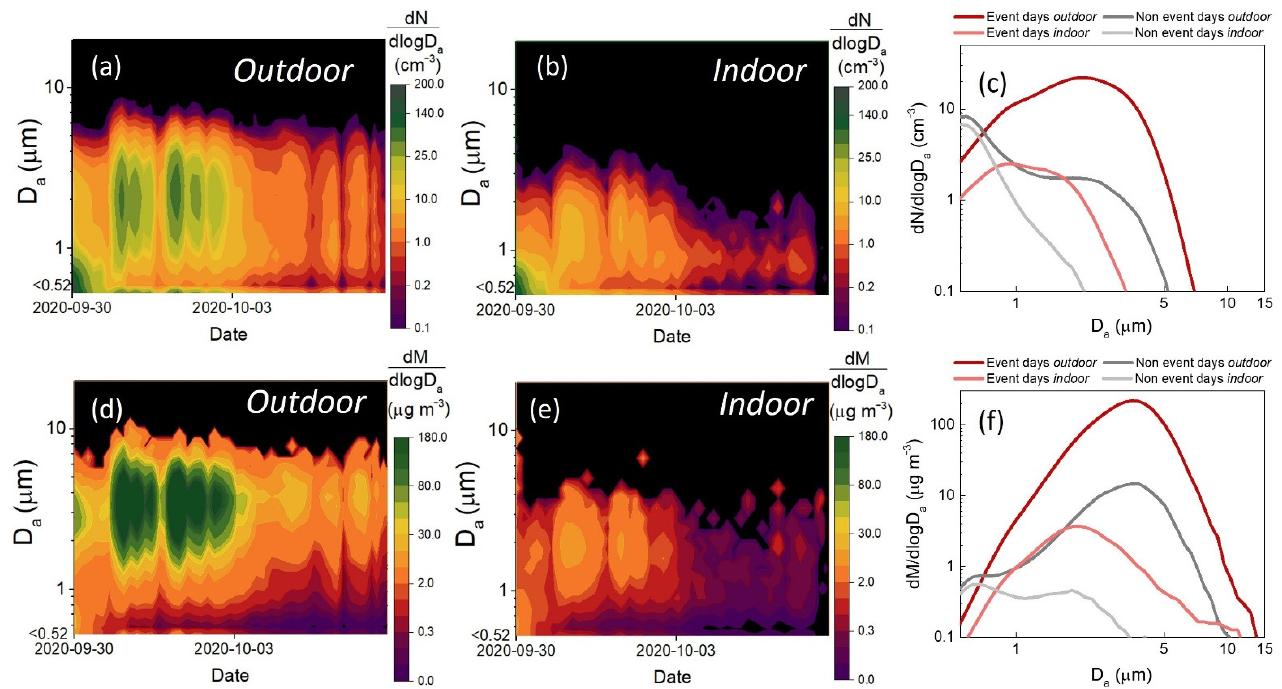
Figure 6. Particle number size distribution in outdoor ( a ) and indoor ( b ) air together with their averages for the event and non-event days ( c ). Particle mass-weighted size distribution in outdoor ( d ) and indoor ( e ) air together with their averages for the event and non-event days ( f ).